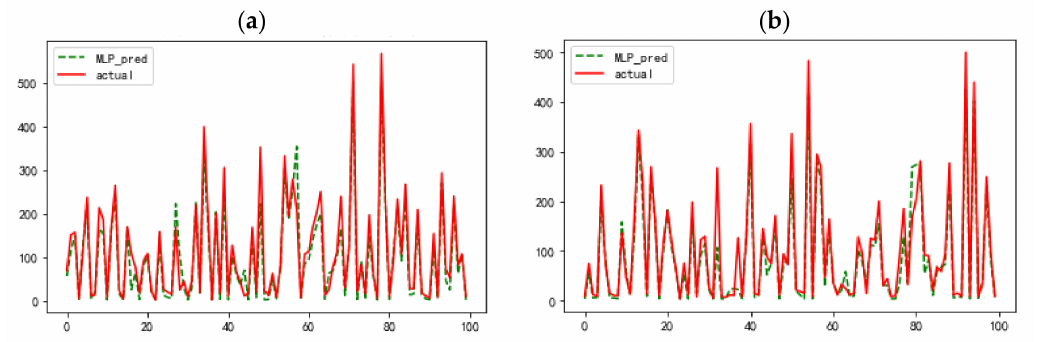
Figure 11. MLP neural network prediction results: ( a ) 100 random samples in the first 50% of the test set, ( b ) 100 random samples in the last 50% of the test